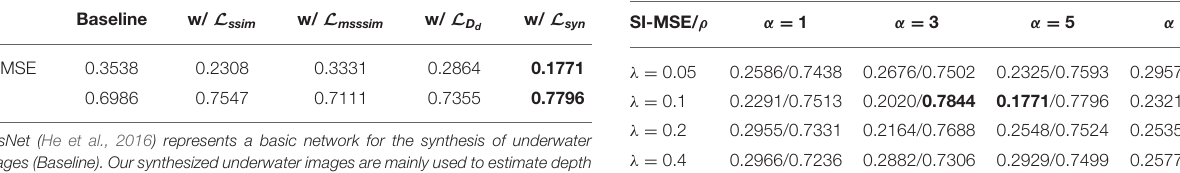
TABLE 5 | Comparison of weights used in the objective function of our model, including α and λ . SI-MSE/